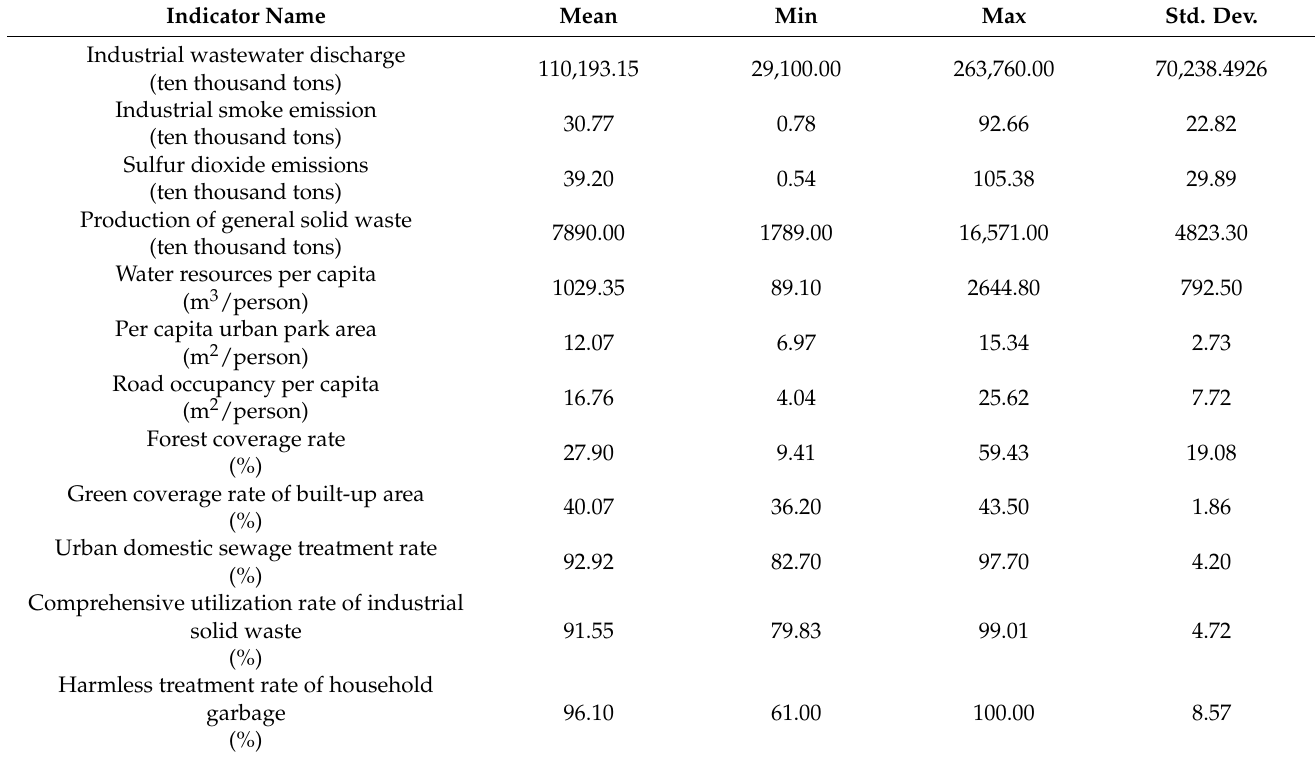
Table 3. Descriptive statistics of eco-environmental quality index evaluation